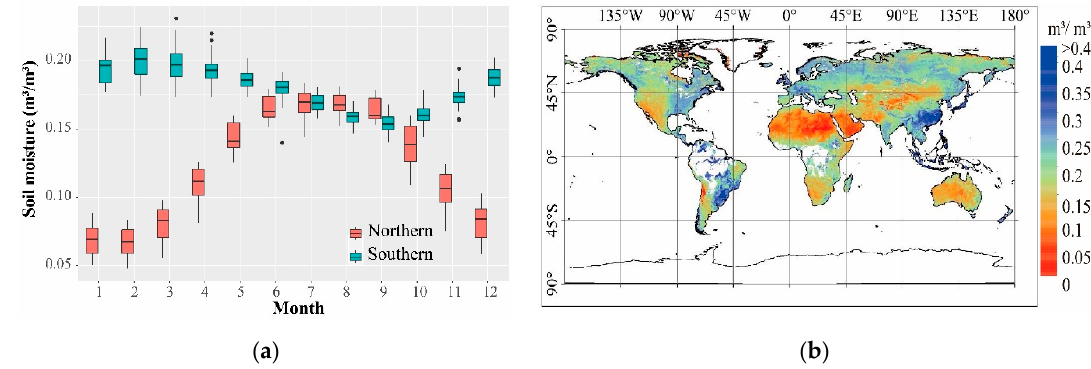
Figure 3. ( a ) Statistics of global average soil moisture (SM) at monthly scale in 1979–2016; ( b ) global pattern of SM average over the 1979–2016 period.